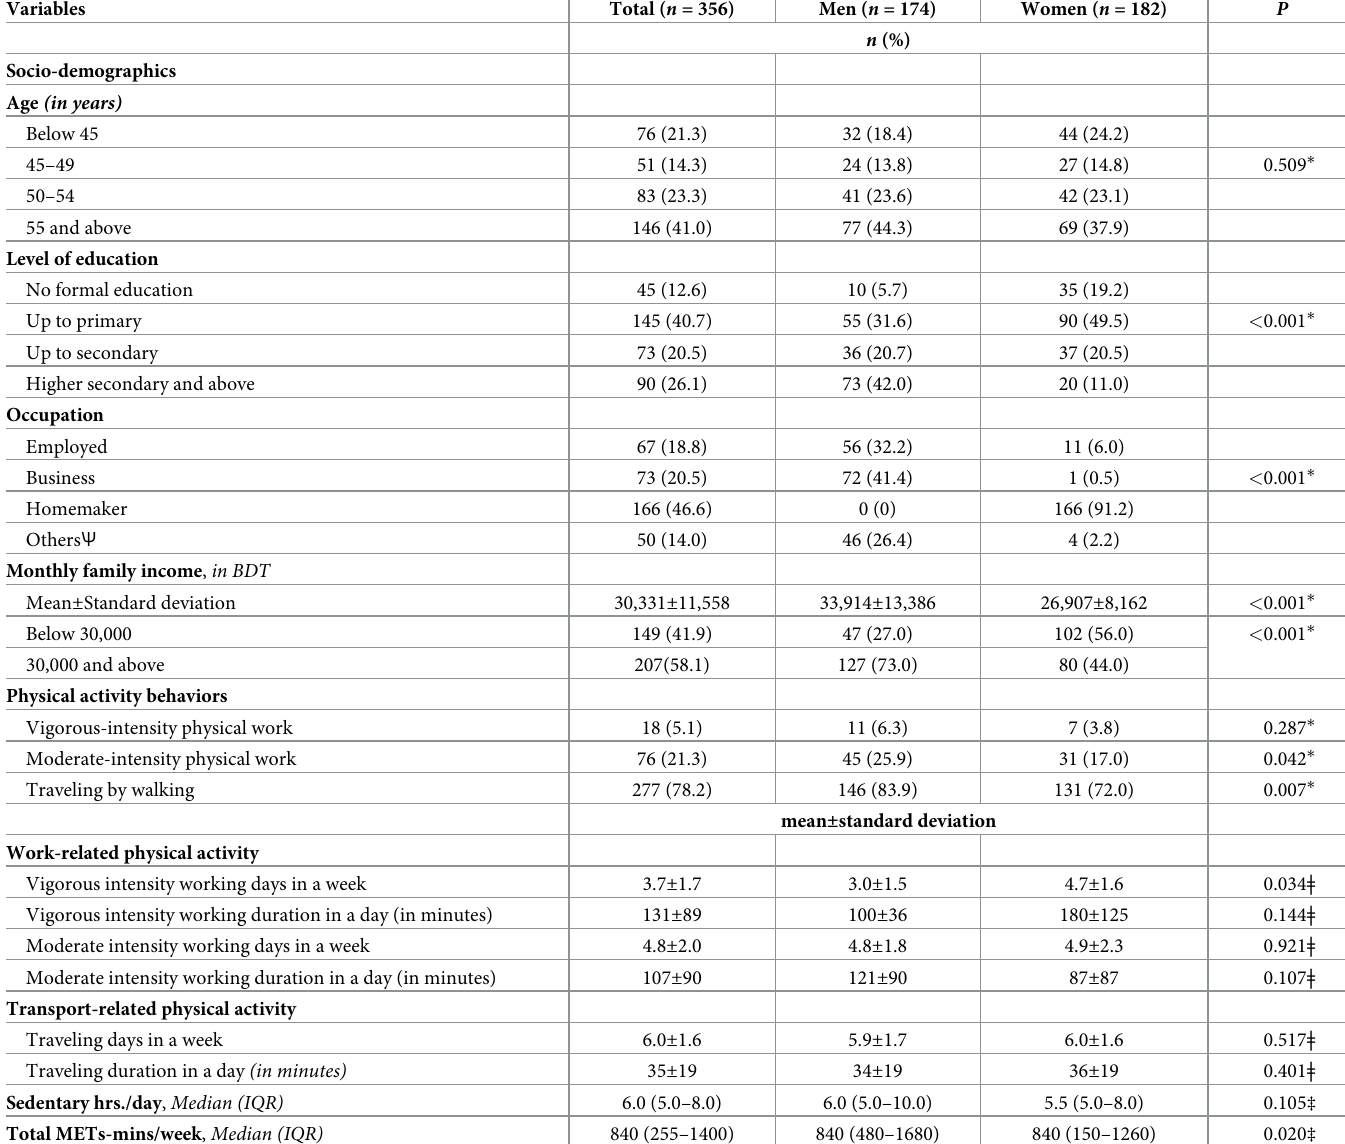
Table 1. Population characteristics and GPAQ domain-wise physical activity